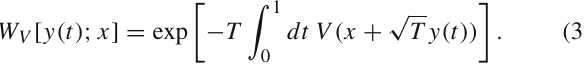
considering a 3 dimensional sphere with a radius of 4 µ m separated from an infinite flat plate by a separation of 4 µ